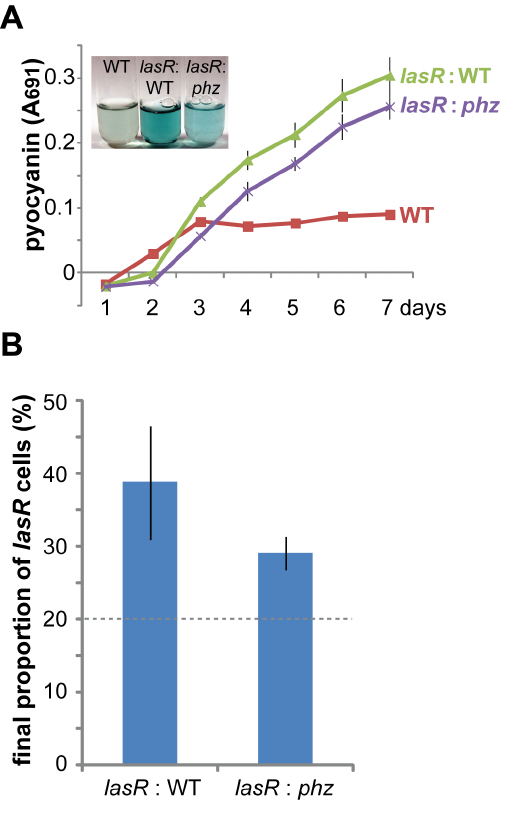
Figure 5. A lasR mutant contributes pyocyanin in a cheating mixture. Starting mixtures were 1:4 lasR mutant to PA14 or PA14 phz . All plots show the mean 6 standard deviation of 3 biological replicates. A. Pyocyanin quantification in shaking M9-casein medium at 25 u C. Inset shows appearance of cultures after 7 days of incubation. B. Relative proportions of lasR mutant cells in the indicated mixtures after 7 days of incubation. The difference between the two mixtures was not significant ( p